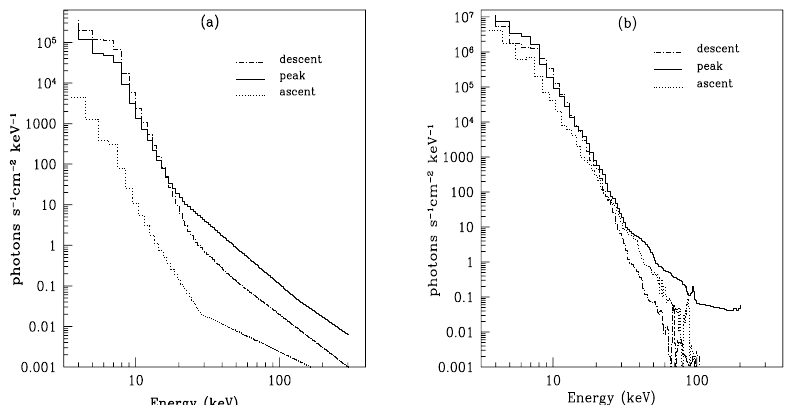
Fig. 2. Spectra at three phases (dotted: ascent phase; solid: peak; dash-dotted: descent phase) of the (a) M-class flare and the (b) X-class flare which are used in this paper. The spectra were obtained from the RHESSI satellite data and the OSPEX software.